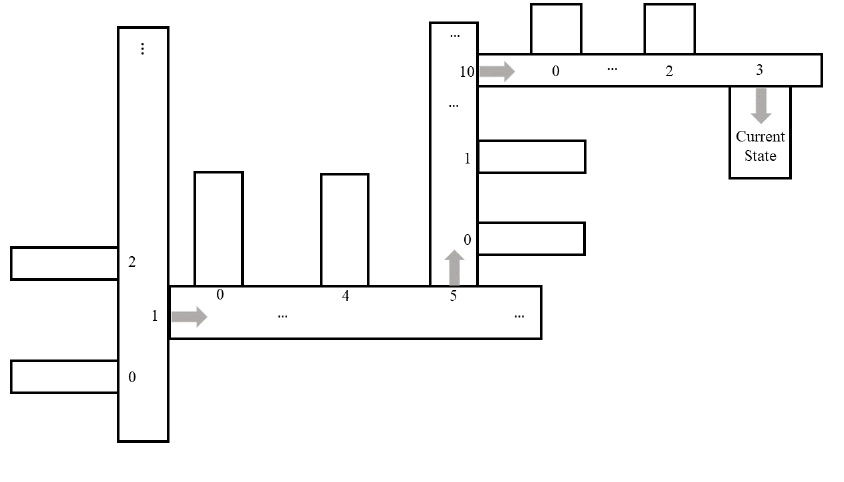
Figure 10. A visualization of the sliding window and respective current state used in the large